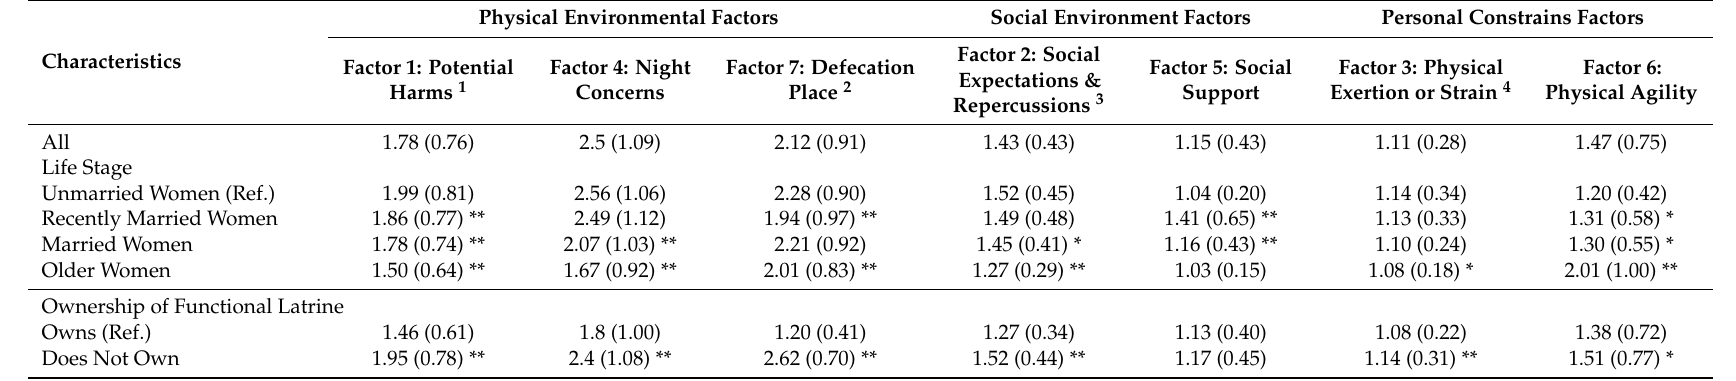
Table 3. Sanitation Insecurity factor scores by life stage and ownership of a functional